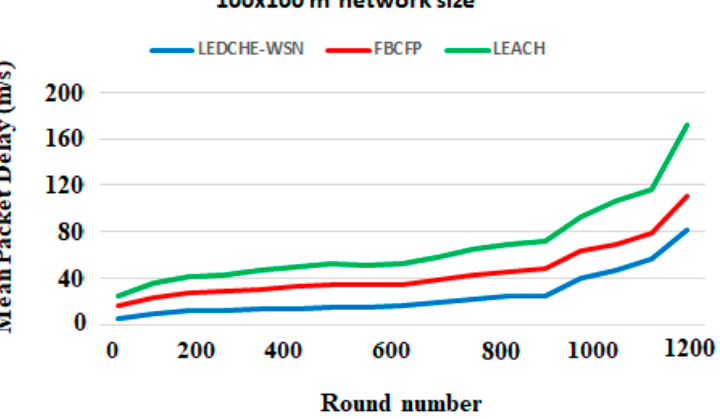
Figure 8. Mean package delay considering 100 × 100 m network size for LEACH, FBCFP, and LED- CHE-WSN protocols